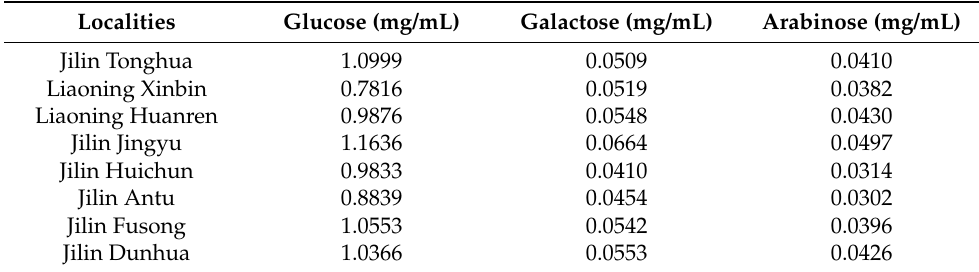
Table 3. Results of composition determination of RG